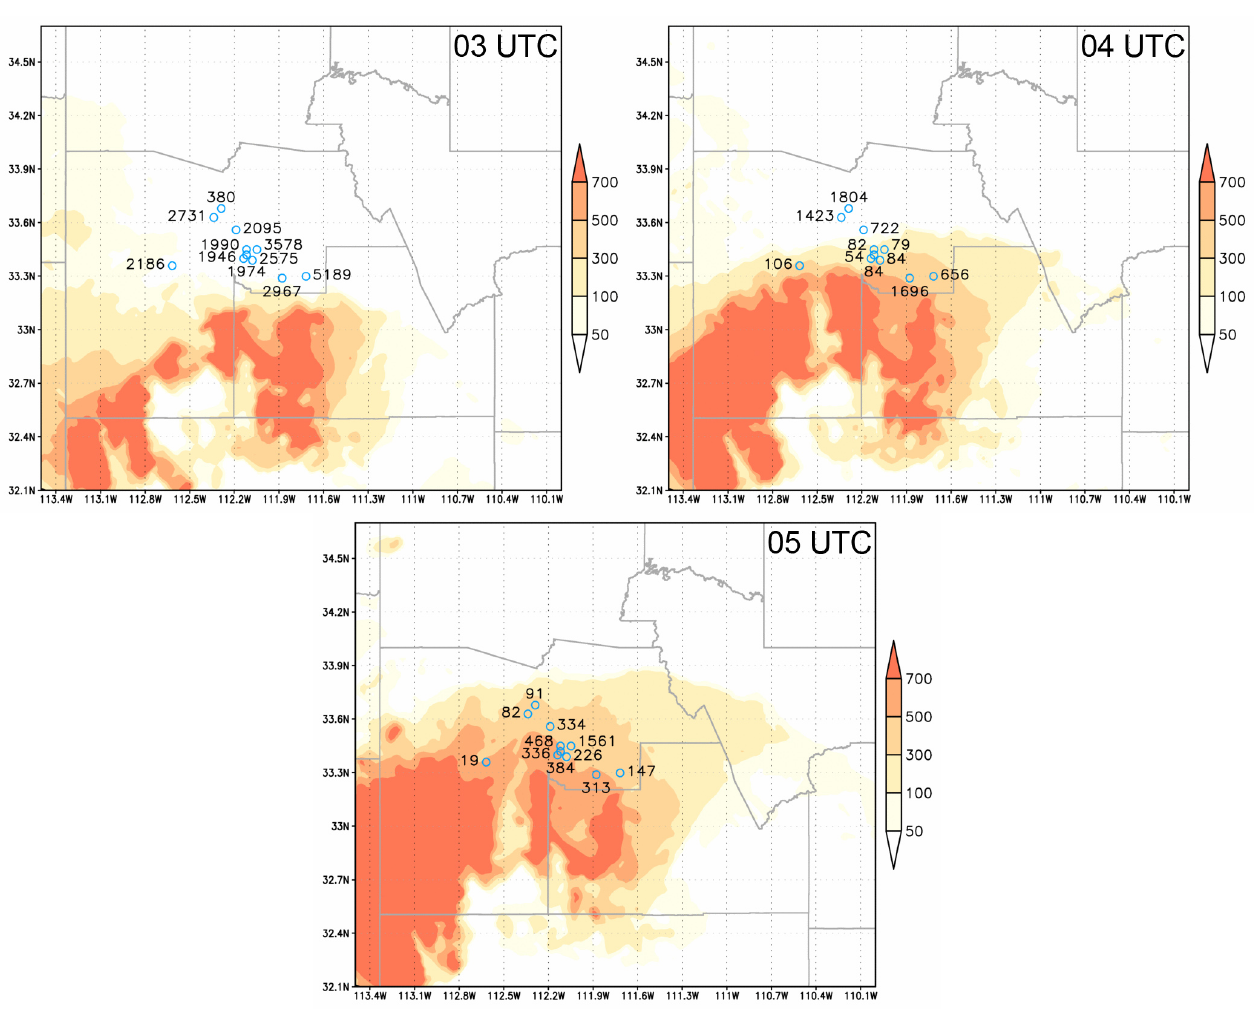
Fig. 9. NMME–DREAM PM 10 surface dust concentration and observed values of PM 10 (µgm − 3 ) at 03:00 (upper left), 04:00 (upper right), and 05:00 (lower) UTC 6 July